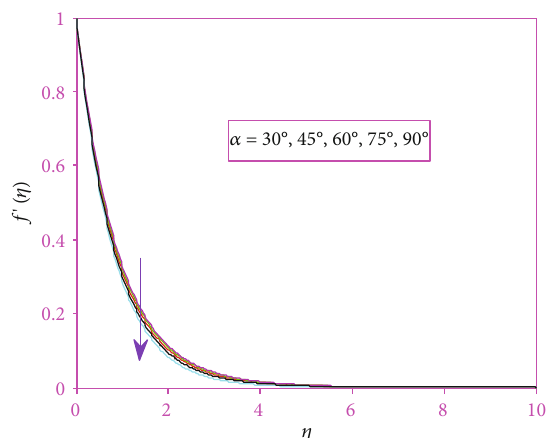
Figure 4: Velocity distribution for di ff erent inclinations.